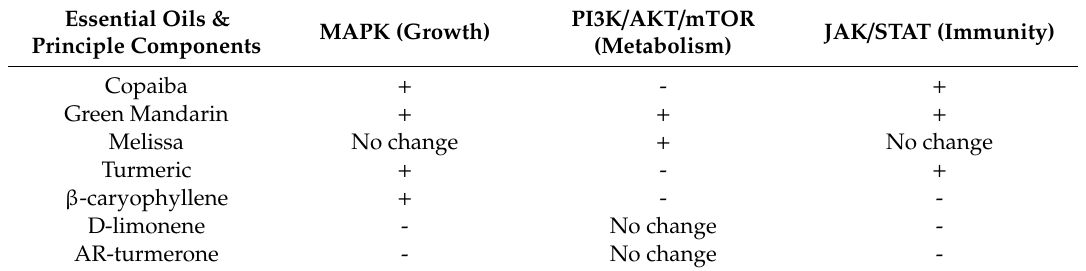
Table 1. Regulation of cellular signaling pathways by essential oils and their principle